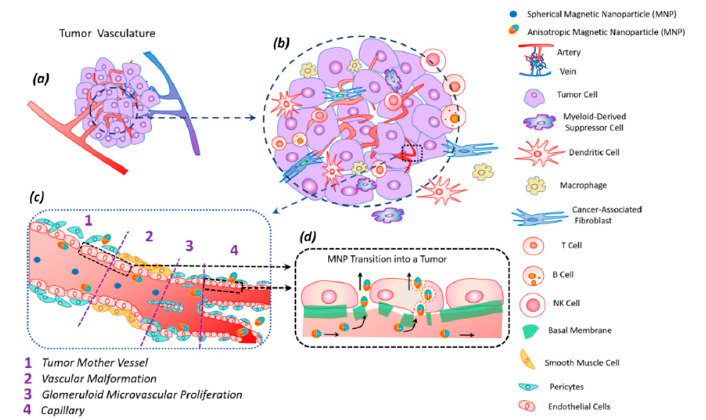
Figure 5. Tumor vasculature ( a ) in a complex tumor microenvironment (transformed and immune cells) ( b ). Transport of magnetic anisotropic discs and spherical magnetic nanoparticles along